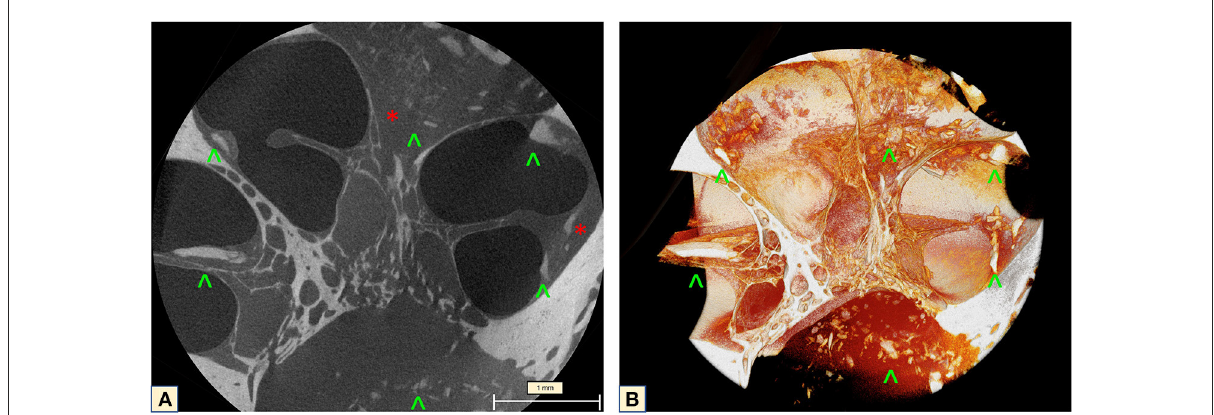
FIGURE5 MicroCT of the cochlea midturn (2.41 µ m): (A) Scattered dense lithic formations (green arrowheads) at the IAC, SL, over the OSL and the apex, combined with extensive fibrotic tissue formation (red stars). (B) Mesh reconstruction in 3D: diffuse distribution of the lithic lesions throughout the wall of the cochlea, the CP, IAC and over the OSL (green arrowheads).